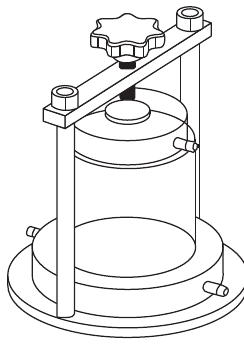
Figure 1: Modified permeameter. Table 1: Physical and chemical properties of soil